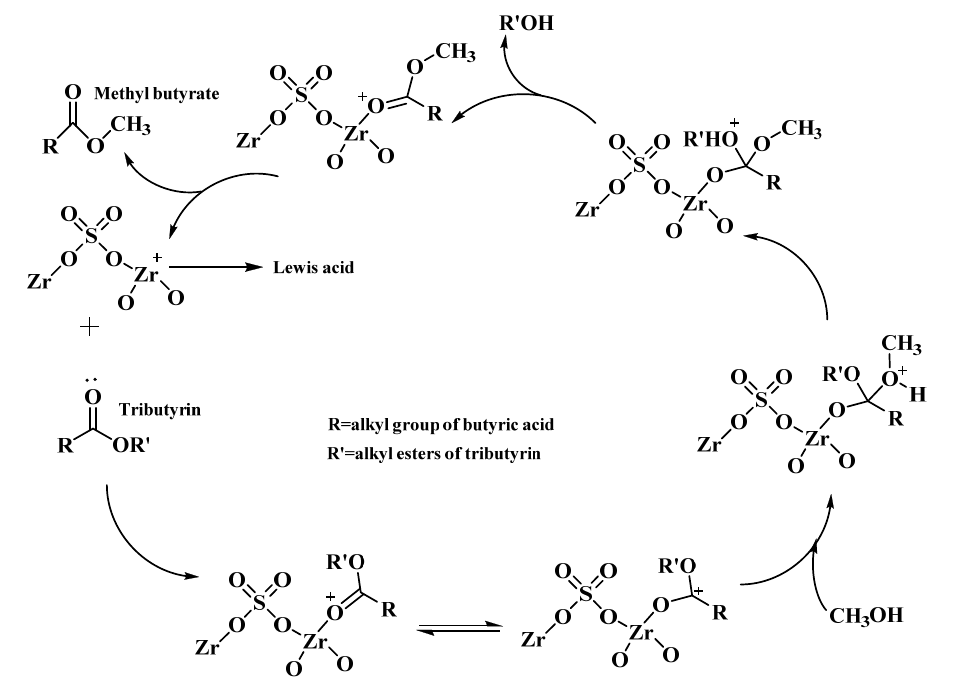
Figure 6. Reaction mechanism of transesterification on mesoporous sulfated zirconia nanosheets. (Adapted with permission from Ref. [60]. Copyright 2020, Royal Society of Chemistry.)